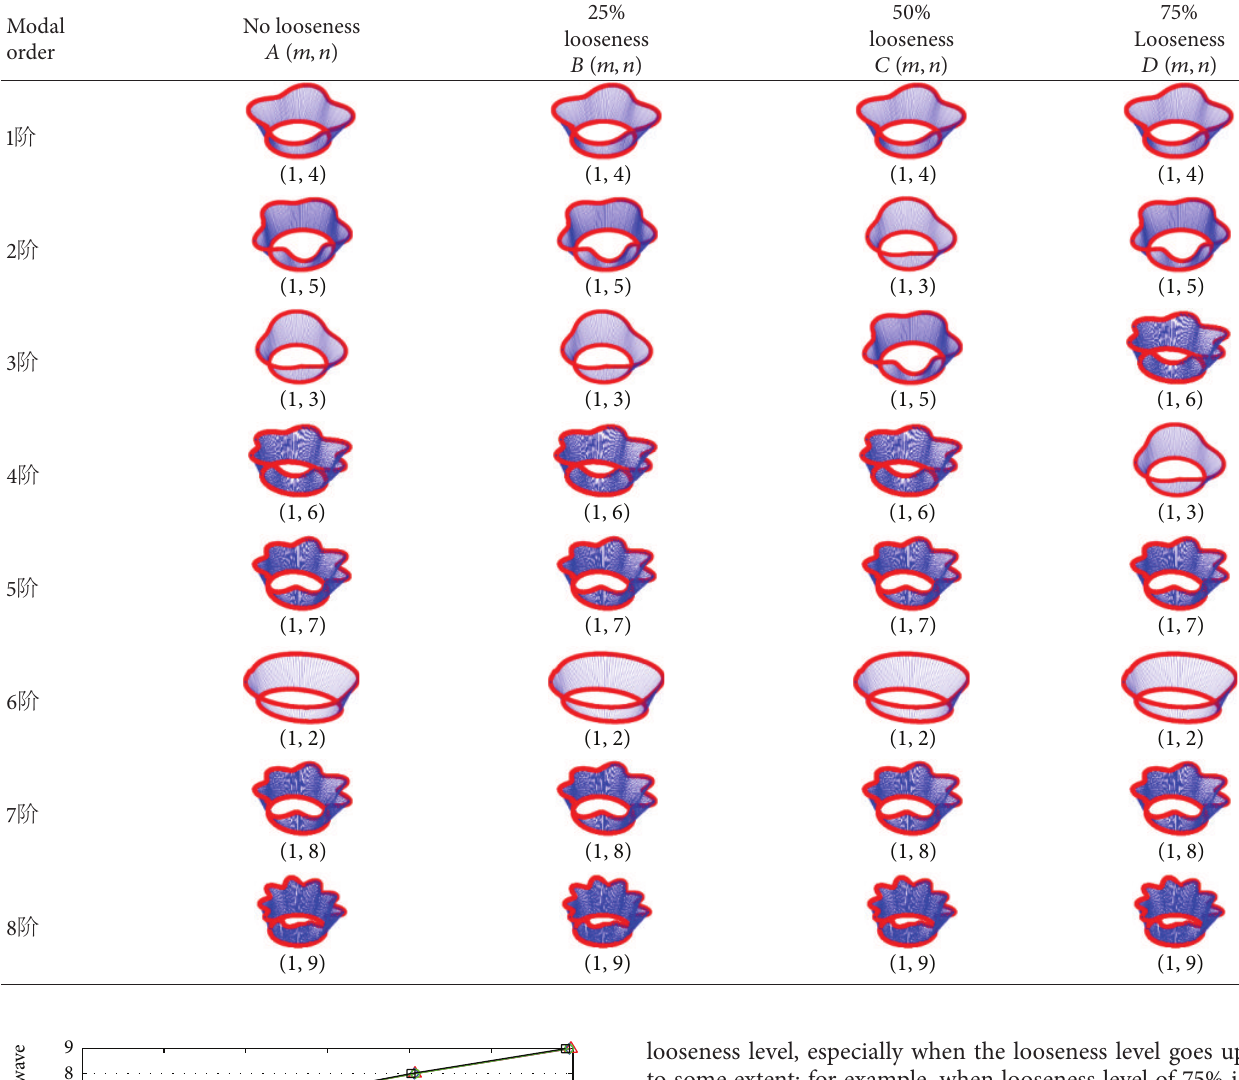
Table 12: Mode shapes of TCS under BLB with different looseness levels.